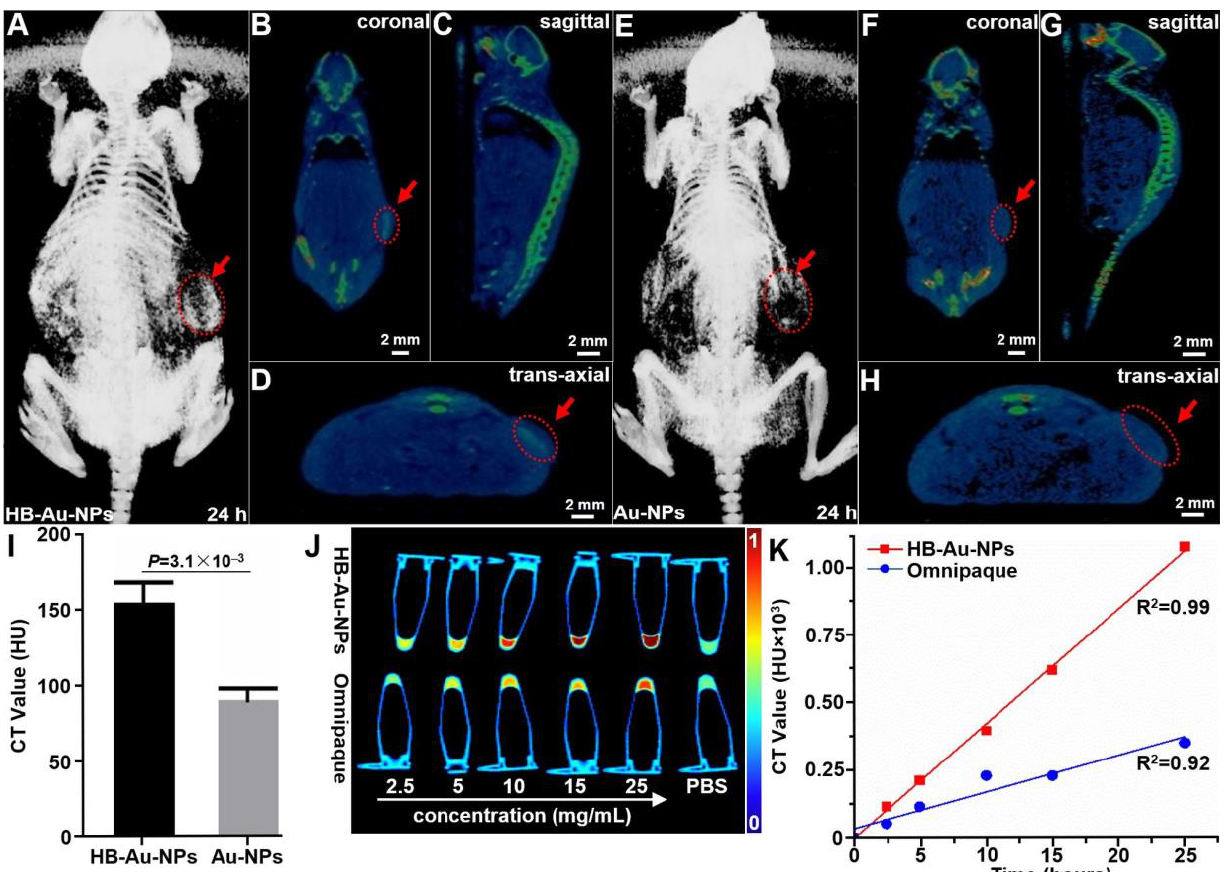
Figure 5. CT images. Representative 3D-reconstructed whole-body CT images at 24 h following intravenous injection of ( A–D ) HB-Au-NPs and ( E–H ) Au-NPs are shown. The locations (arrows) of implanted human OE33 xenograft tumors are shown in the axial, sagittal, and coronal views. ( I ) Quantified results showed a mean value of 155.08 ± 14.94 HU for HB-Au-NPs and 90.47 ± 9.05 HU for Au-NPs from n = 3 animals, p = 3.1 × 10 − 3 by unpaired t-test. ( J ) CT image of HB-Au-NPs and Omnipaque in vials at different concentrations, including 0 (PBS), 2.5, 5, 10, 15, and 25 mg/mL). ( K ) Intensities increase linearly with concentration of HB-Au-NPs, R 2 = 0.99, and Omnipaque, R 2 =